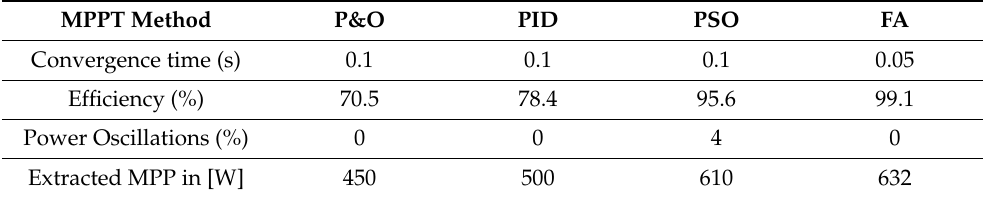
Table 8. Performance comparison of FA, P&O, PID and PSO (Case 4).